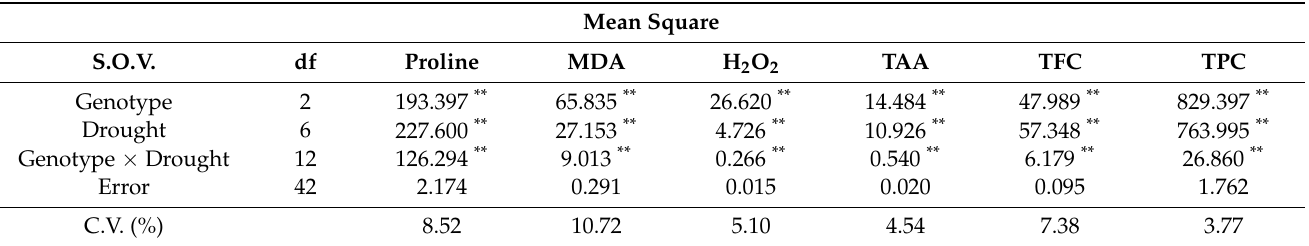
Table 3. The ANOVA for the effects of PEG and sorbitol on the biochemical traits of three melon genotypes under in vitro conditions. Mean Square